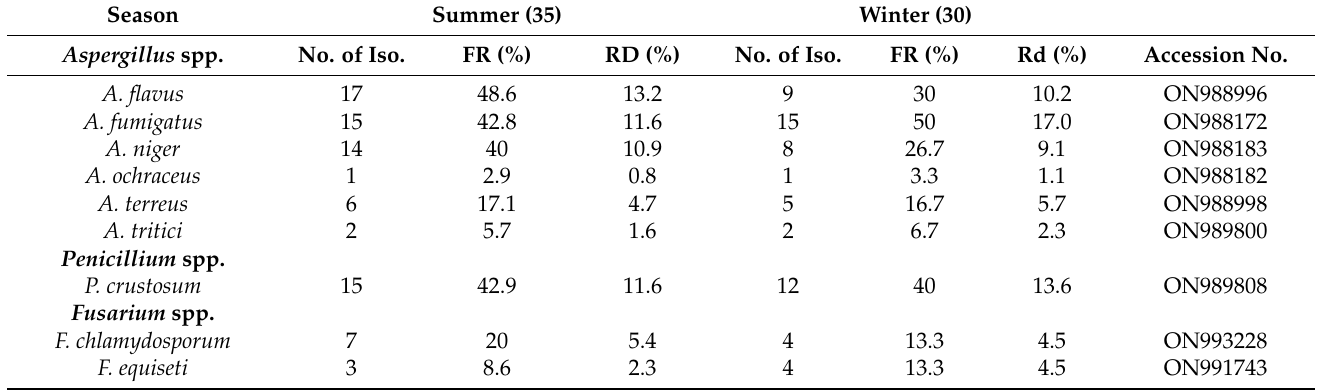
SD = standard deviation; DF = degree of freedom; T = t-value. The frequency of isolation and relative density of the different fungal species isolated from the feed samples over the two seasons are reported in Table 3. Among the 217 fungal species recovered in this study, 129/217 (59%) of them were recovered from the summer feeds, and 88/217 (41%) from the winter feeds. However, A. fumigatus was the most dominant, with a low incidence of 42.8% in the summer feeds and a high incidence of 50.0% in the winter feeds. This was closely followed by P. crustosum , which was more prevalent in summer samples (42.9%) than in winter samples (40.0%). A. flavus and A. niger also were, respectively, recovered at higher incidence rates of 48.6 and 40.0% during the summer compared to 30.0 and 26.7% recorded during the winter. Other less frequently isolated Aspergillus spp. found in feeds from both seasons included A. terreus , A. tritici and A. ochraceus . Table 3. Isolation frequency and relative density of fungal species recovered from smallholder dairy cattle feeds and feed ingredients in Free State and Limpopo provinces, SA. Winter (30) Aspergillus spp. No. of Iso. FR (%) RD (%) No. of Iso. Rd (%) Accession